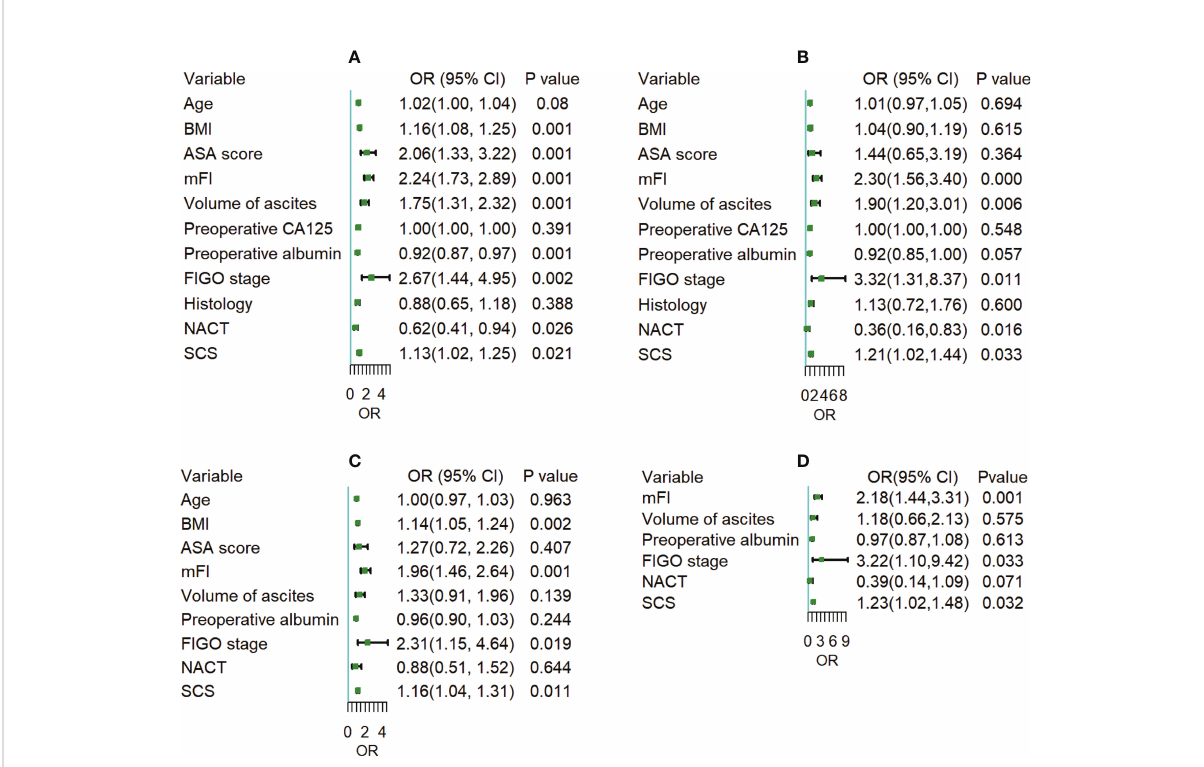
FIGURE 2 (A, C) Univariate and multivariate logistic regression analysis for the odds of 30-day postoperative overall complications; (B, D) Univariate and multivariate logistic regression analysis for the odds of 30-day postoperative severe